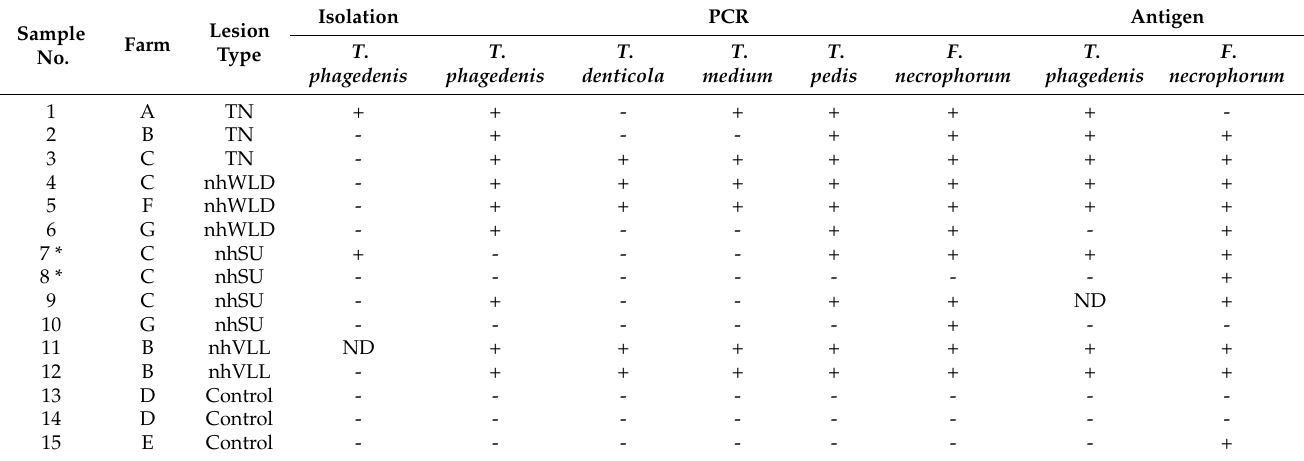
Figure 1. Three samples of healthy foot skin from two dairy farms in Hiroshima Prefecture (D and E) were collected at a slaughterhouse after confirming that the cattle had been raised on NHCL-free farms. Farms A, B, F, and G are free-stall, while farms C, D, and E are tie-stall. Farms A, B, D, E, F, and G were fed a total mixed ration (TMR), and farm C was fed separate rations. Consistent with the incidence of hoof disease, the incidence of NHCL was also observed in a relatively small number of other cows on farms A, B, C, F, and G, but not on farms D and E, where control samples were taken. Regarding treatment history, the dairy cow in sample No. 3 was treated for NHCL by antibiotic application (oxytetracycline 500 mg) for the affected lesion 61 days before sampling. However, 61 days had elapsed since treatment, and furthermore, the clinical findings had not improved. It was therefore added to the sample as not being affected by the drug treatment. The other cows sampled had no history of NHCL treatment prior to sample collection. Regarding other hoof disease history, the dairy cow that sampled No. 5 was treated for WLD 83 days prior to sampling, but the other sampled cows had no other hoof disease history. Samples Nos. 7 and 8 were taken on the same day from different hind hooves of the same cattle with nhSU. Before sampling, the lesions were washed with tap water using a soft brush to remove fecal material. Biopsy samples were obtained using a 6 mm diameter sterile dermal biopsy punch or a sterile scalpel under sedation or local anesthesia. The biopsy samples were placed in Mitsuoka’s anaerobic buffer [19] in a sterilized tube, held at 4 ◦ C, and transported to the laboratory at the University of Miyazaki within 48 h after sampling. Table 2. Culture isolation, PCR detection, and immunohistochemistry of Treponema spp. and F. necrophorum